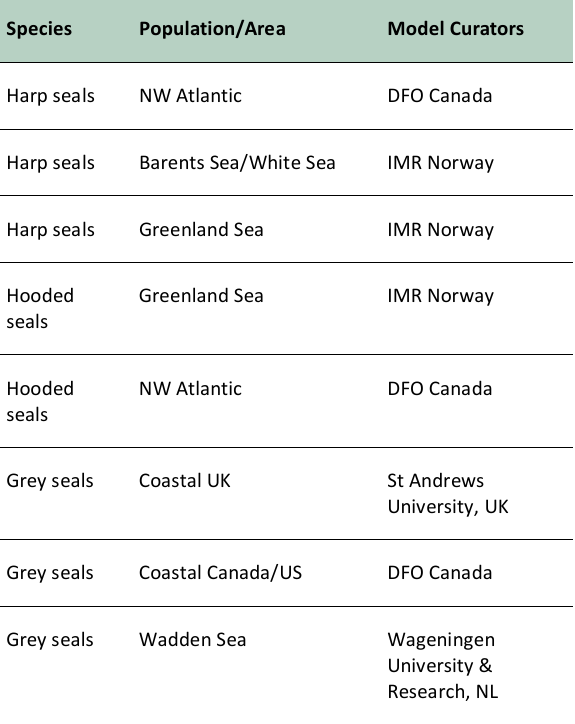
Table 1. Seal population models compared at the